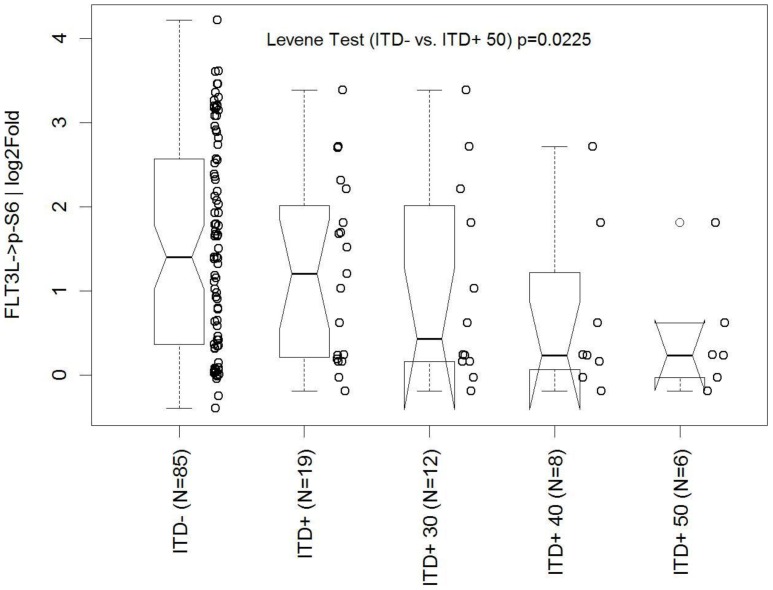
Comparison of FLT3 ITD signaling versus FLT3 WT signaling.Box and whisker plots of FLT3L-induced p-S6 with the log2fold metric in increasing mutational load (ITD−[FLT3 WT] = 0%, ITD+[FLT3 ITD]≥0%, ITD+30≥30%, ITD+40≥40%, ITD+50≥50% ITD, respectively). This is the primary objective analysis.